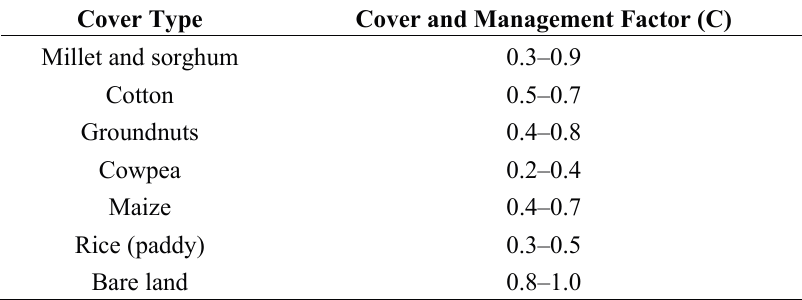
Table 2. Crop Cover and Management Factor for selected crops